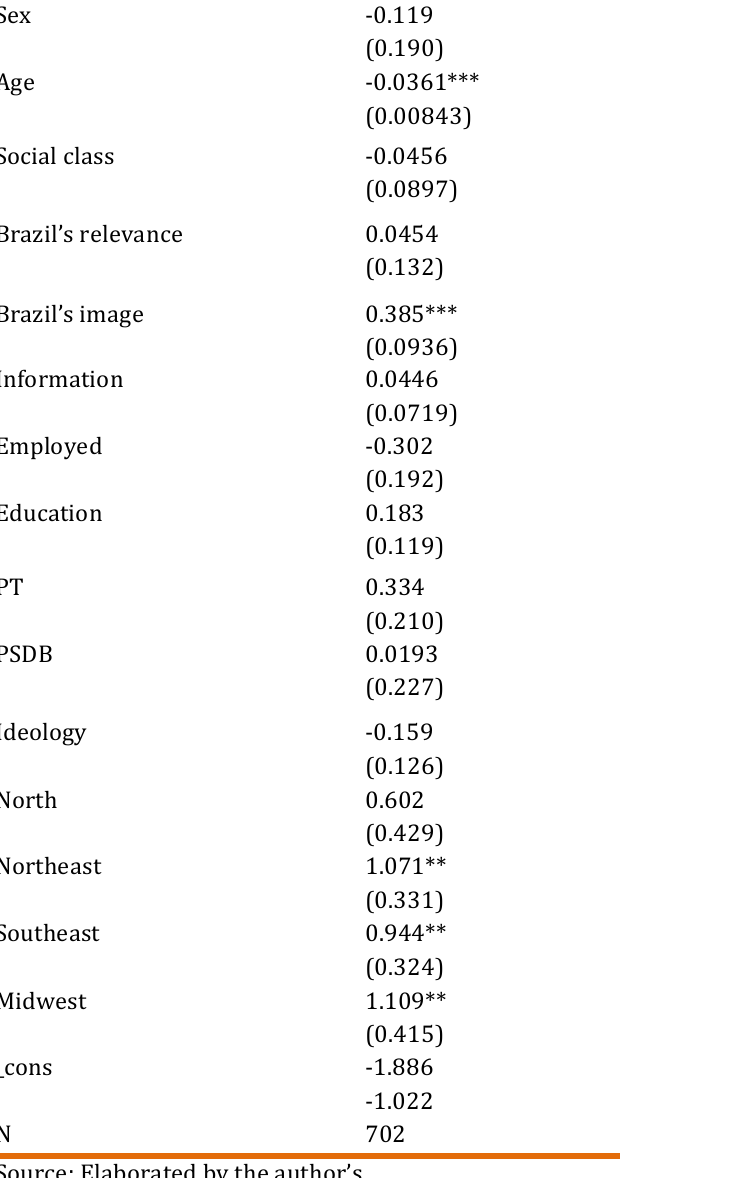
Table 01. Foreign aid support without treatment effects Foreign aid